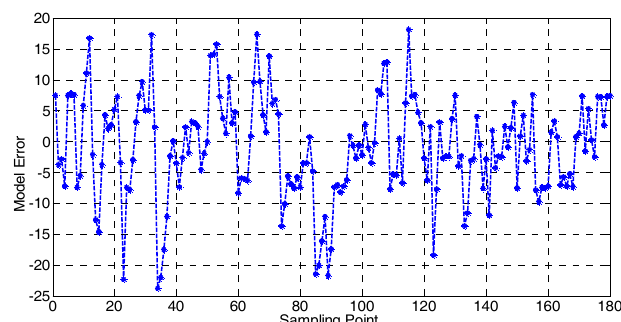
Figure 15. The result of the SVM model.